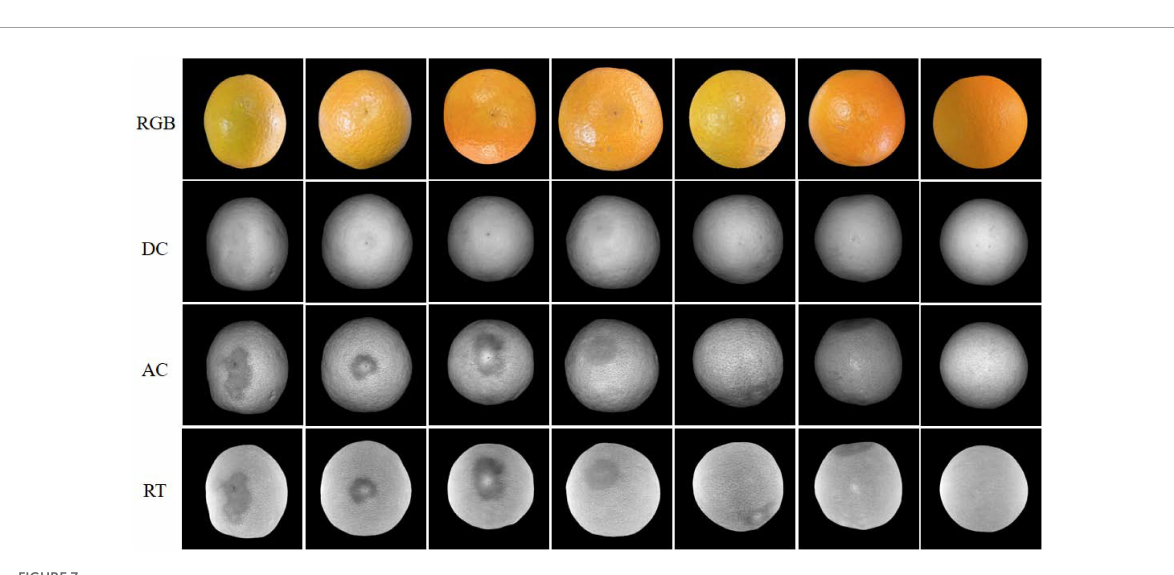
FIGURE7 RGB, DC, AC, and RT images of the representative orange